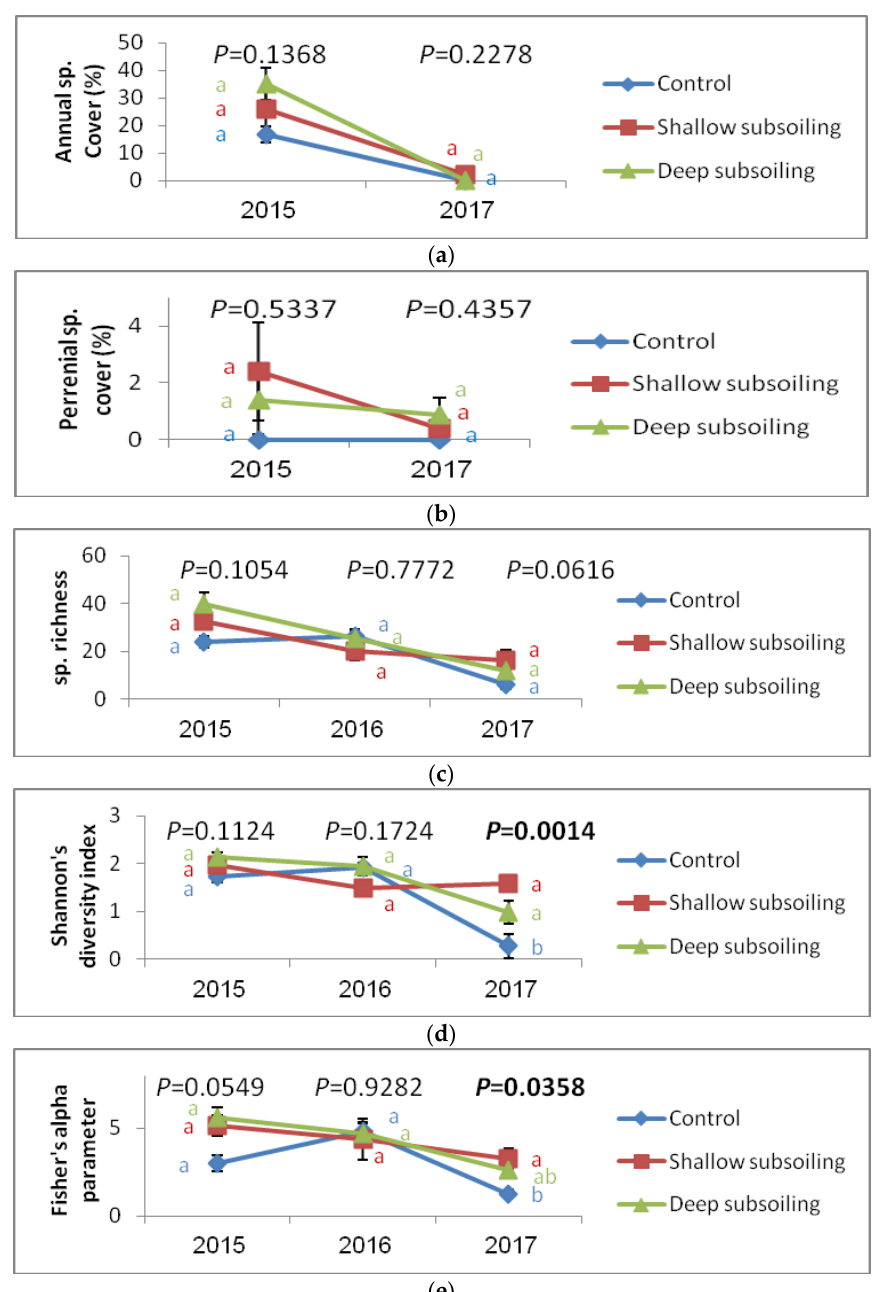
Figure 2. Treatment effect (according to year) on vegetation parameters, including: annual species cover ( a ); perennial species cover ( b ); species richness ( c ); Shannon’s diversity Index ( d ); and Fisher’s alpha parameter ( e ). Notes: Bold P value indicates a significant effect. Means within a year followed by a different letter differ at the 0.05 probability level according to Tukey’s honestly significant difference (HSD). Error bars represent standard error (SE) of the means.